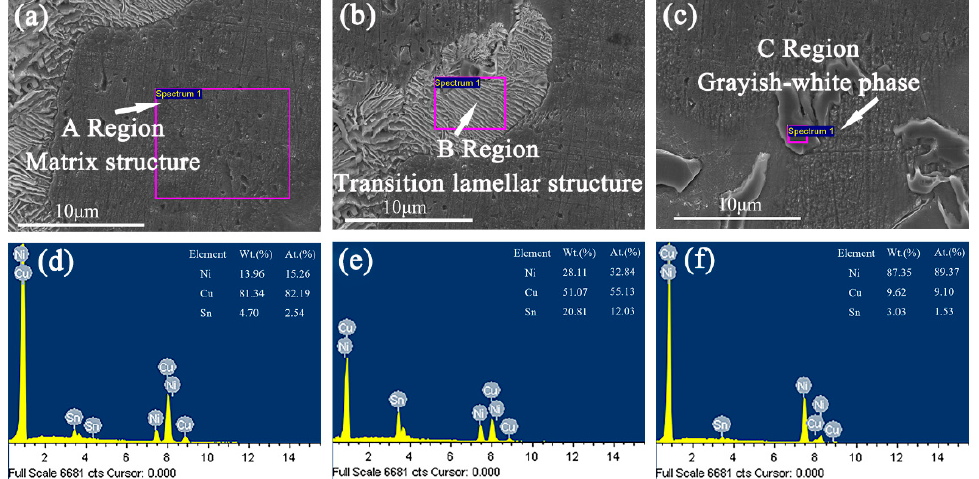
Figure 5. The SEM images of as-cast structure for Cu–15Ni–8Sn–0.3Mo alloy: ( a , d ) matrix structure, ( b , e ) transition lamellar structure, ( c , f ) grayish-white phase.